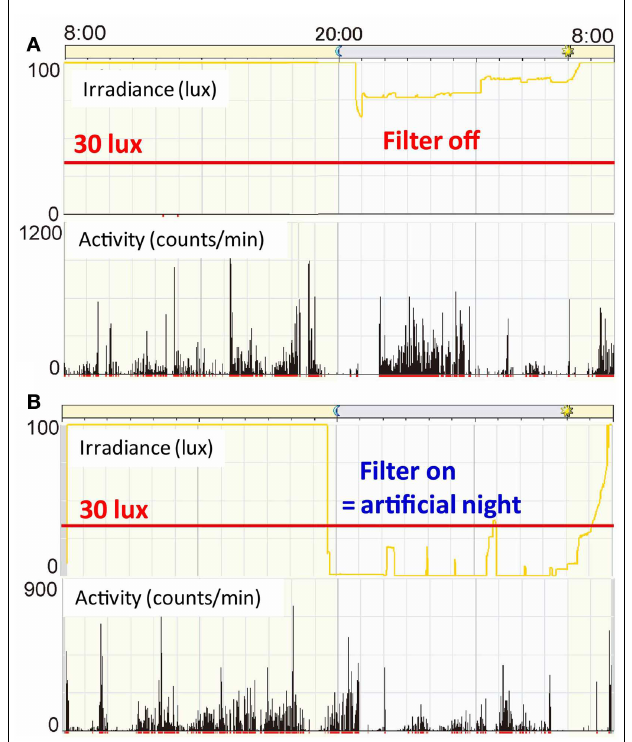
Figure 11 is the summary data of day/night activity ratios at two developmental stages. At 38 weeks gestational age, preterm infants with the filter were more active during the day than at night (day-night ratio: 1.46 ± 0.15 SE) and t -test revealed a statistical difference between the two groups